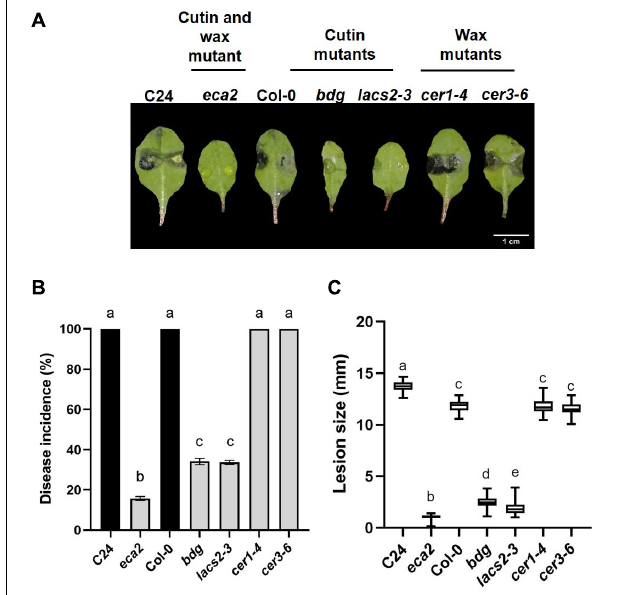
FIGURE 1 | Differential phenotypic response of cuticular mutants to B. cinerea. Leaves of WT plants C24 and Col-0 and the cuticular mutants eca2 , bdg , lacs2-3 , cer1-4 , and cer3-6 were infected with B. cinerea . Disease symptoms on rosette leaves after 72 hpi (A) , disease incidence (B) , and lesion size (C) were evaluated. Three independent experiments were done (n = 60 ± SD). Different lowercase letter columns indicate significant difference, according to one-way analysis of variance (ANOVA) ( p -value < 0.001) followed by Tukey test. Representative pictures are